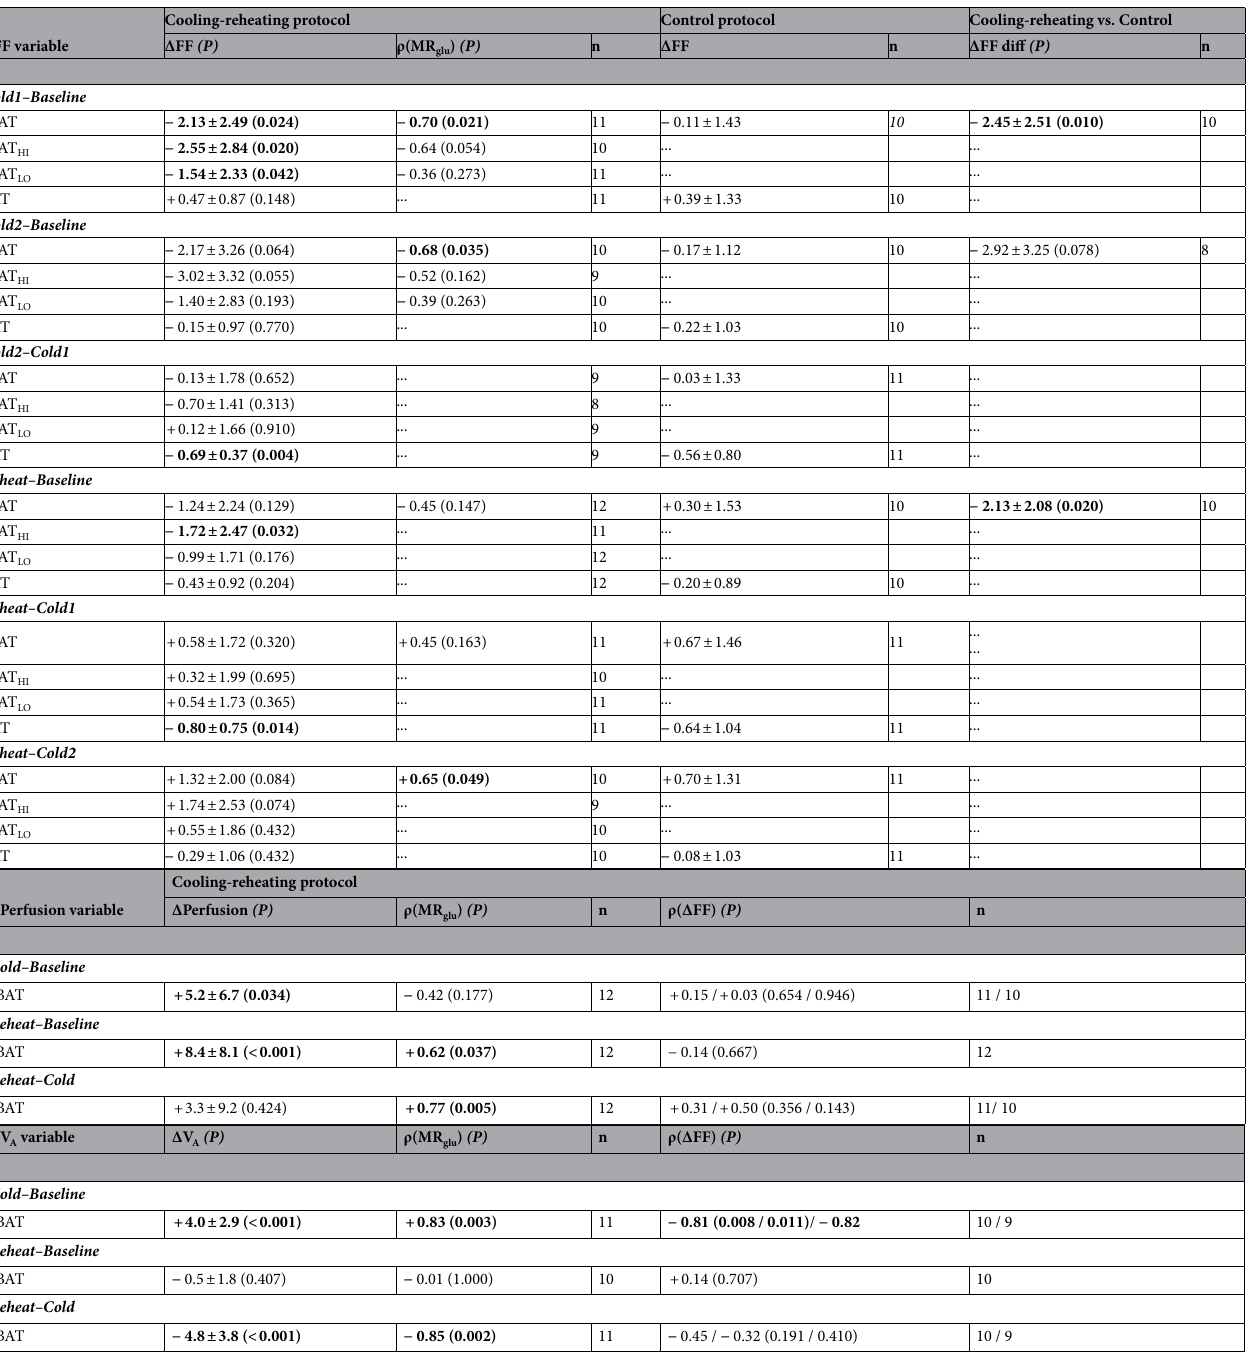
Table 3. Changes in (A) FF within sBAT and SAT, (B) perfusion and (C) V A within sBAT, presented side by side with the correlation between these changes and MR glu and ΔFF (estimated within the same segmentation, correlation with ΔFF only conducted for perfusion and V A ), during the Cooling-reheating protocol. (A) also presents changes in FF during the Control protocol and whether these changes are different from those of the Cooling-reheating protocol. Mean ± standard deviation. Δ, change between two time points during either protocol, calculated by subtracting the earlier measurement from the later: diff, difference calculated by subtracting the Control protocol measurement from the Cooling-reheating protocol measurement: /, separation between changes in FF calculated with respect to cold scan 1 (left) and cold scan 2 (right). Units: ΔFF, percentage points (pp); Δperfusion, ml/100 cm 3 /min; ΔV A , ml/100 cm 3 . ···, not estimated. n, number of observations. Changes were evaluated using Wilcoxon signed-rank test. Spearman rank-order correlation was used between MR glu (or ΔFF) and changes in FF, perfusion and V A . ρ, Spearman rank-order correlation coefficient. Statistical significance ( P < 0.05) in bold